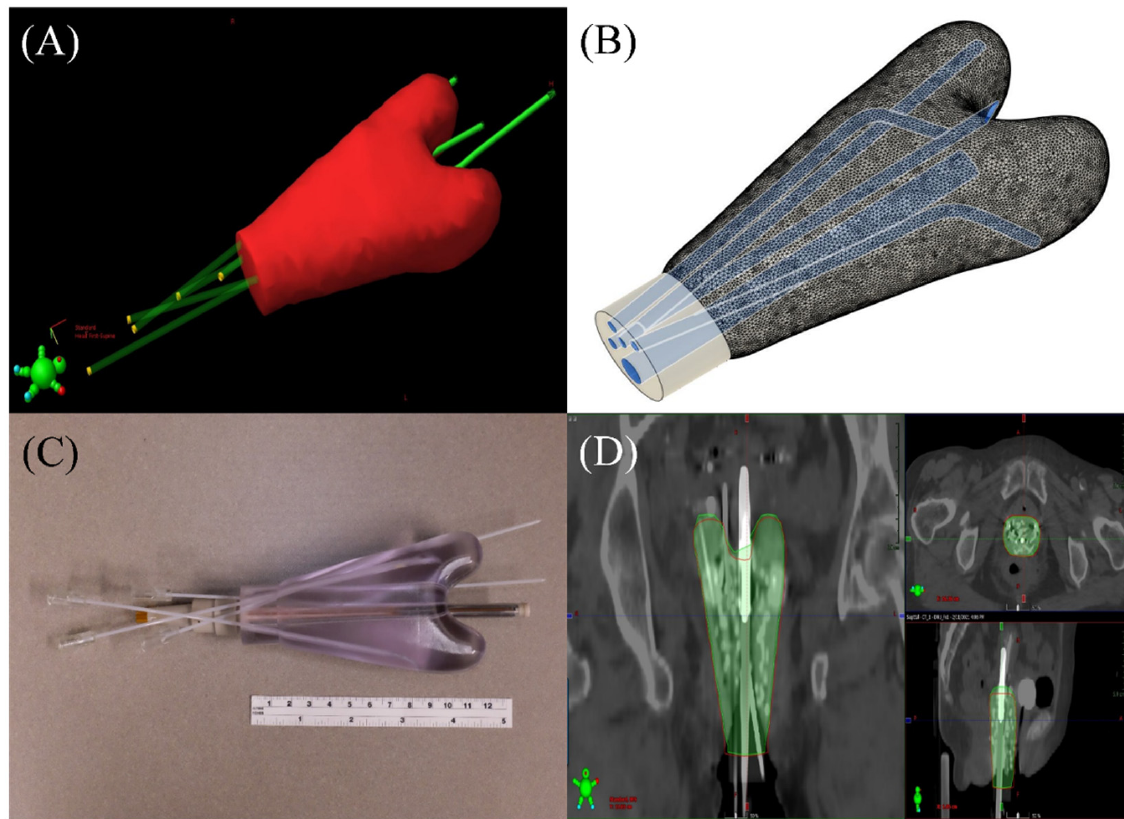
Figure 4. The 3D model and the printed version of the vaginal template with the two needle tracks, the two ovoid tracks, and the DMBT tandem are illustrated. ( A ) The vaginal space contour with the needles and applicator tracks are defined. ( B ) The subsequent 3D model of the template with the tracks are generated for 3D printing. ( C ) The printed 3D vaginal template with the needles and a prototype direction modulated brachytherapy (DMBT) tandem inserted for imaging and QA. ( D ) Image registration between the planning CT and the CT of the vaginal template are performed to evaluate and confirm the accurate printing of the 3D template.